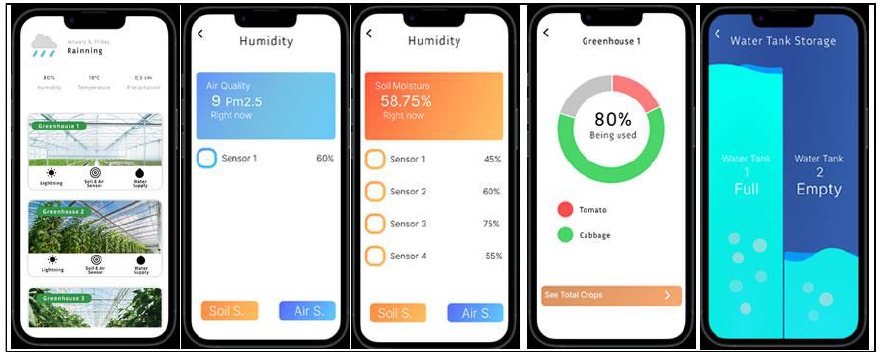
Figure 26. SmartGreen APP.